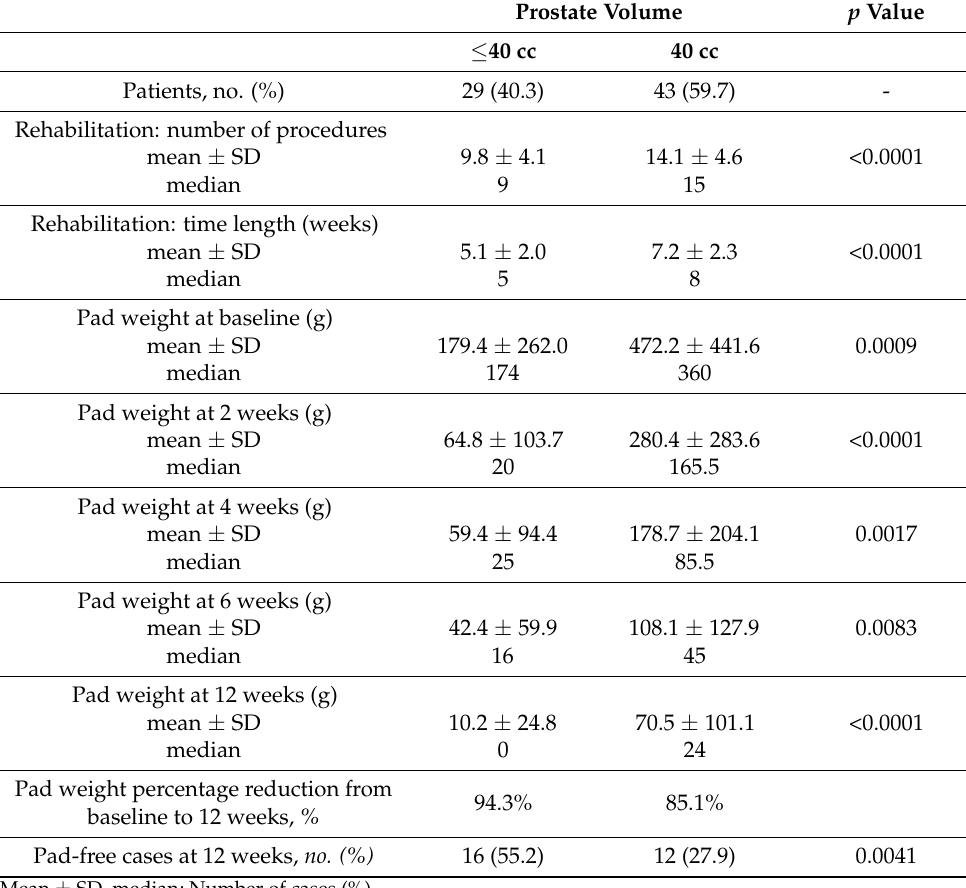
Table 2. Comparison of PAD weight results on the basis of prostate volume (Two-tailed t -test).